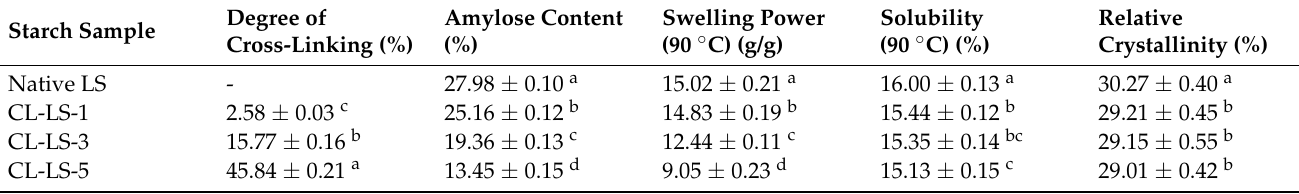
Table 1. Physicochemical properties and relative crystallinity of native and modified starches. Starch